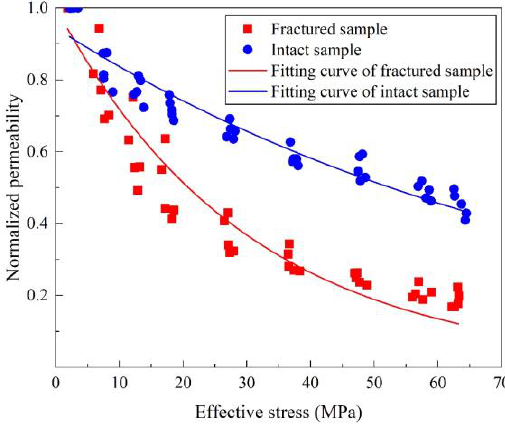
Figure 4. The experimental normalized permeability.